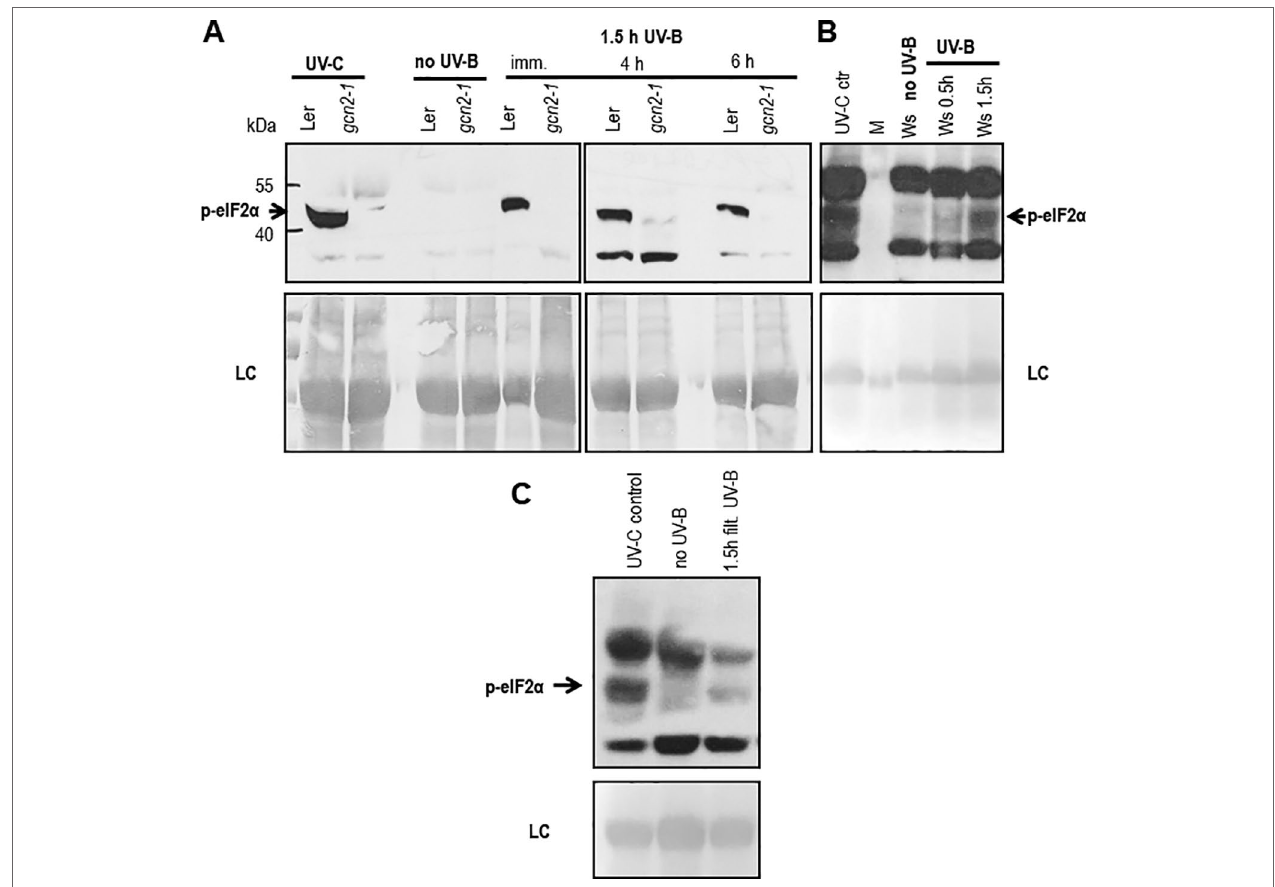
FIGURe 1 | Western blots assessing the activation of GCN2 via eIF2α phosphorylation. (A) Wildtype (Ler) and gcn2-1 plants were either treated 20 min with UV-C (control) or with white light supplemented for 1.5 h with 8 µmol m -2 s -1 broad band UV-B. Leaves were harvested immediately (imm.), 4 h and 6 h after UV-B shut down. (B) First signs of eIF2α phosphorylation (p-eIF2α) is detectable already 30 min after the onset of 10 µmol m -2 s -1 broad UV-B. (C) Also 1.5 h of filtered broad band UV-B exposure is activating GCN2. Equal amount of protein (20 μ g) was loaded on 10% sodium dodecyl sulfate polyacrylamide gel electrophoresis. LC, Loading